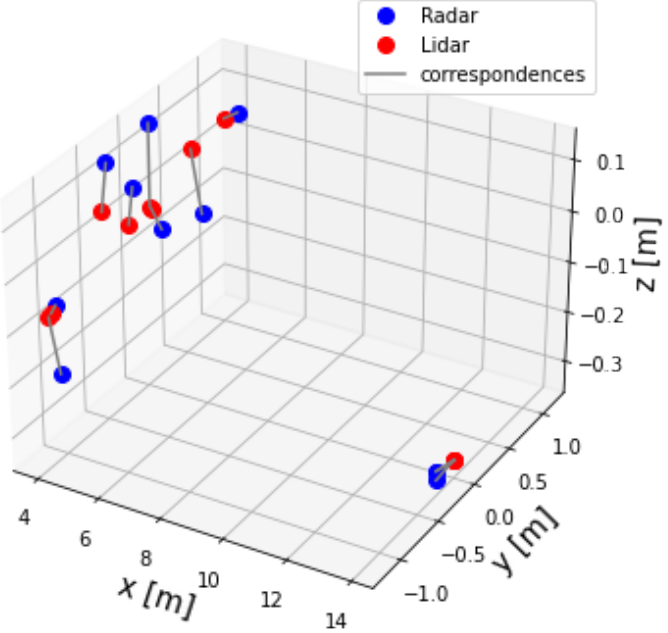
Figure 13. Lidar and radar pointsets after